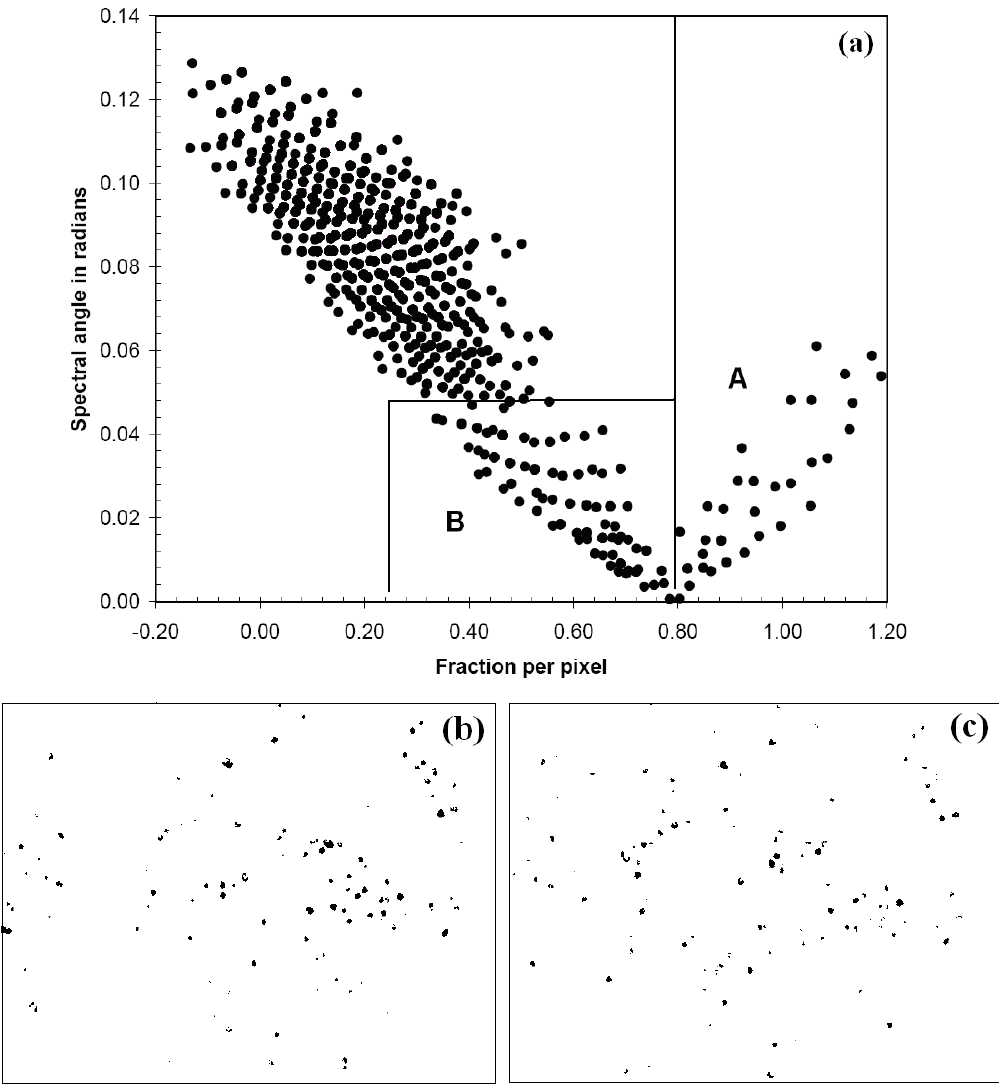
Figure 4. (a) Scatter plot of T. guayacan fractional abundance and spectral angle for each pixel of the 2004 data for the area shown in Figure 3. Region A (fraction > 0.80) on the plot represents the purest pixels of flowering T. guayacan tree. Region B (0.25<fraction<0.80 and spectral angle <0.05) represents partially mixed pixels with flowering T. guayacan tree. (b) and (c) display all pixels encompassed by scatterplot Region A and B for 2004 and 2002